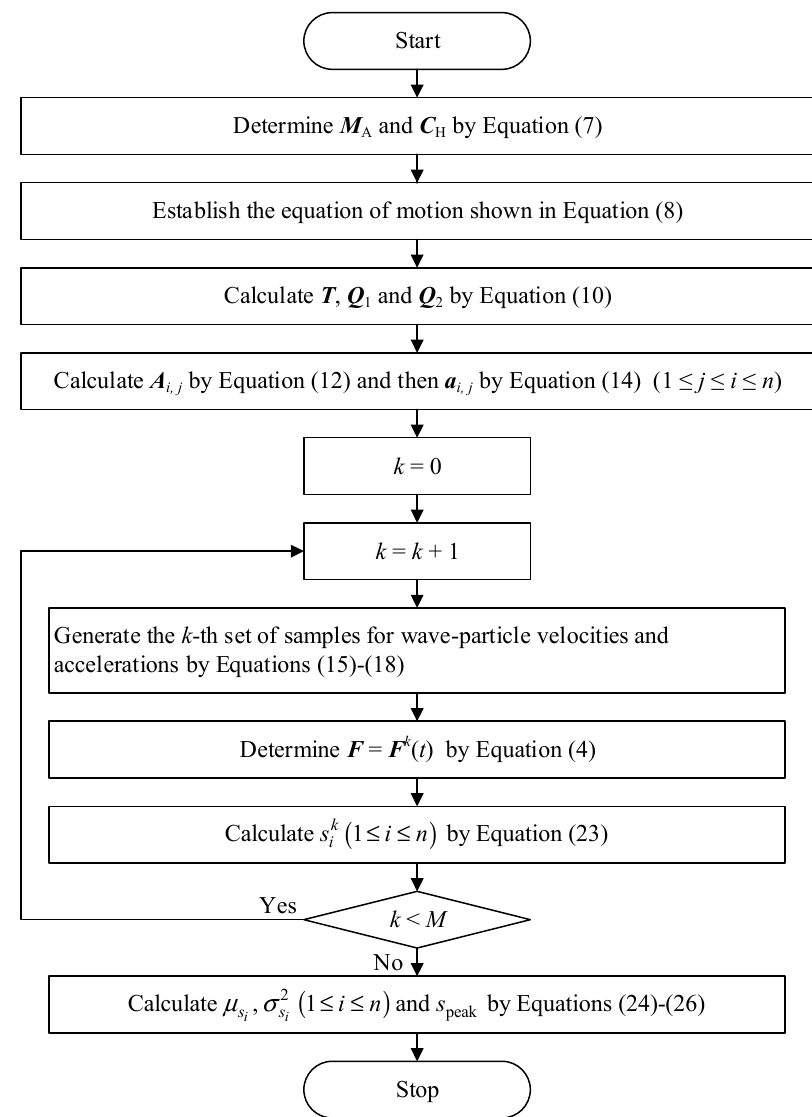
Figure 4. Flowchart for the explicit time-domain method (ETDM)-based Monte Carlo simulation (MCS).